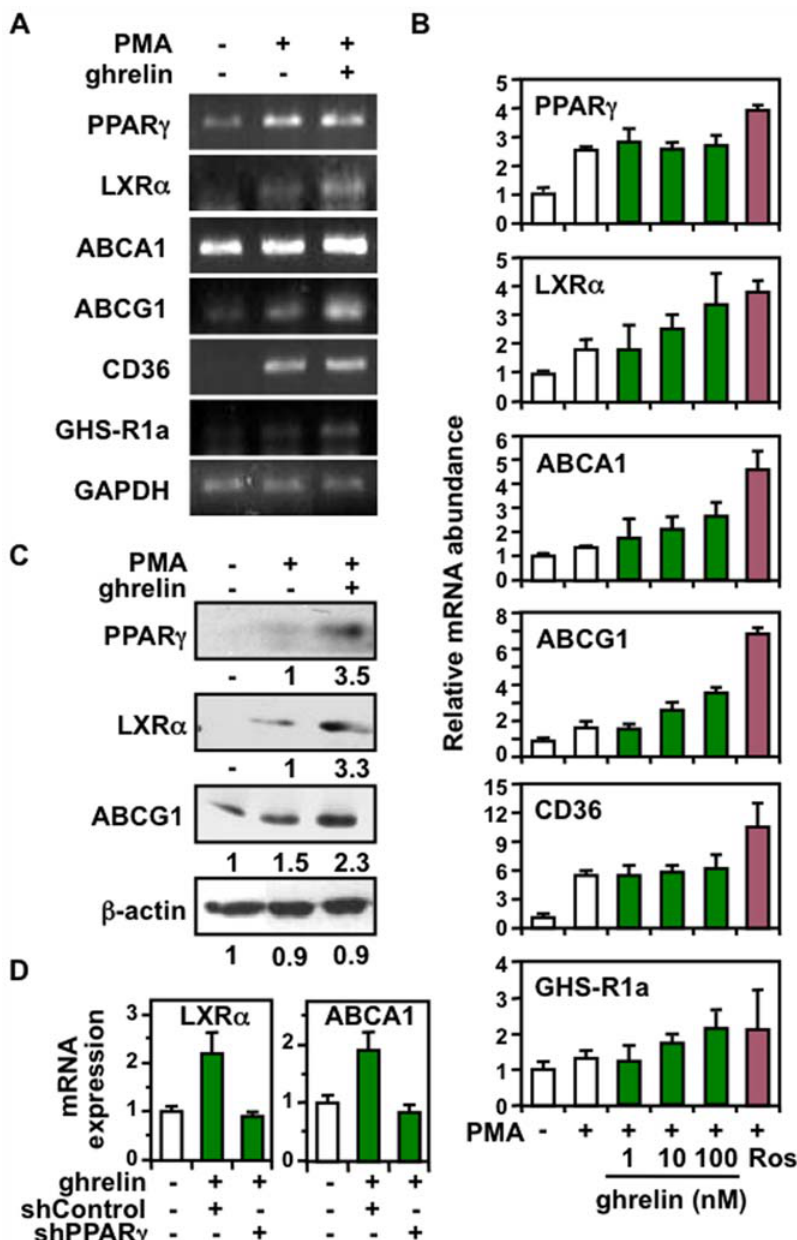
Figure 1. Ghrelin stimulates the PPAR c -LXR a -ABC pathway in THP-1 macrophages. ( A ) RT-PCR analysis of PMA-differentiated THP-1 macrophages treated or not with 100 nM ghrelin 48 h. Representative images are shown for the indicated genes. ( B ) Relative mRNA expression of THP-1 cells treated with increasing doses of ghrelin for 48 h. Rosiglitazone was used as a positive control of PPAR c activation. Data are presented as fold changes ( 6 SEM) compared with undifferentiated cells, obtained from three to four separate experiments. ( C ) Representative immunoblot analysis of THP-1 cells treated with 10 nM ghrelin for 48 h. Relative fold changes are indicated. (D) PPAR c is required to mediate gene activation to ghrelin. Real-time gene expression analysis in THP-1 cells treated with 10 nM ghrelin for 48 h. PPAR c expression was silenced by infecting cells with a lentiviral-carrying shPPAR c and compared to a negative control shRNA. Results are normalized to GAPDH expression.